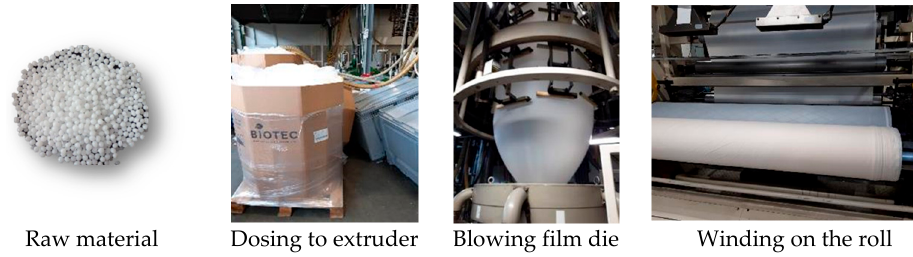
Figure 1. Raw material used for CUT samples preparation and view of extrusion stages.